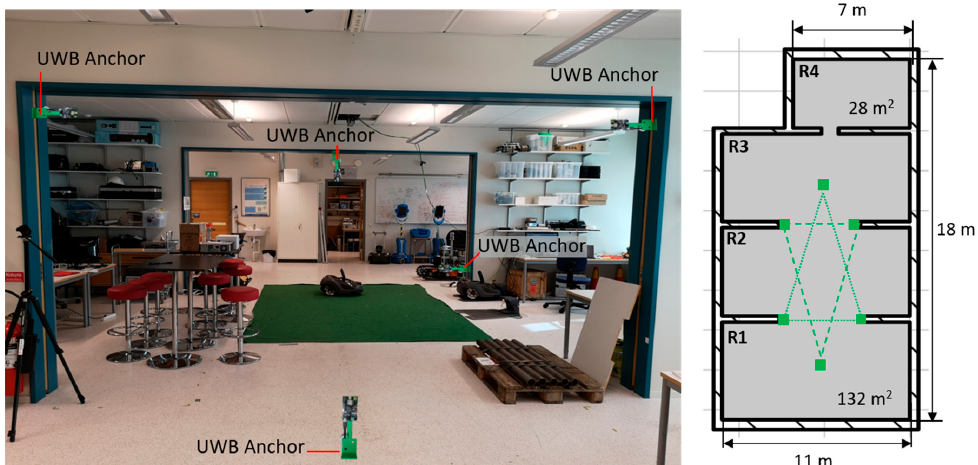
Figure 5. Experimental arena. ( left ) Frontal picture; ( right ) Schematic top view. The green squares indicate the position of the UWB anchors, which are positioned along two inverted triangles (green lines).